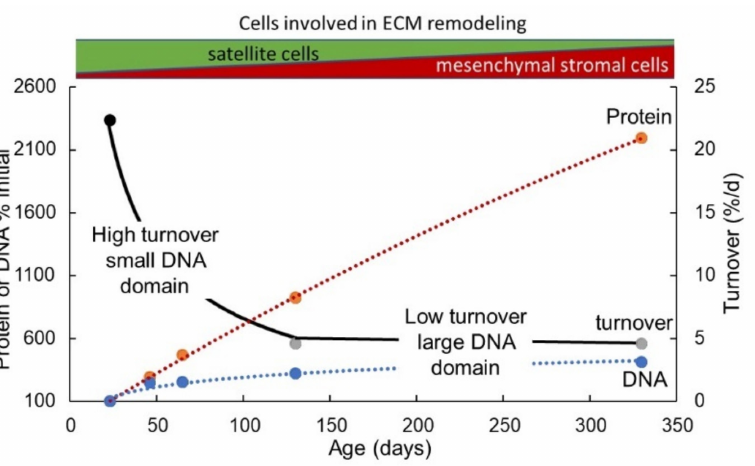
Figure 10. Myofibre growth and protein turnover in rat muscle. At weaning, the protein:DNA ratio is small partly because of a high proportion of satellite cells but also because within the myofibre the DNA domain size is small because each nucleus has to manage protein with a high turnover rate. The fall in the turnover rate with age allows each myonucleus to manage a larger domain allowing rapid growth of myofibre protein. The turnover rate shown is the fractional breakdown rate calculated as the measured in vivo rate of protein synthesis shown in well-fed rats in Table 2 minus the muscle growth rate